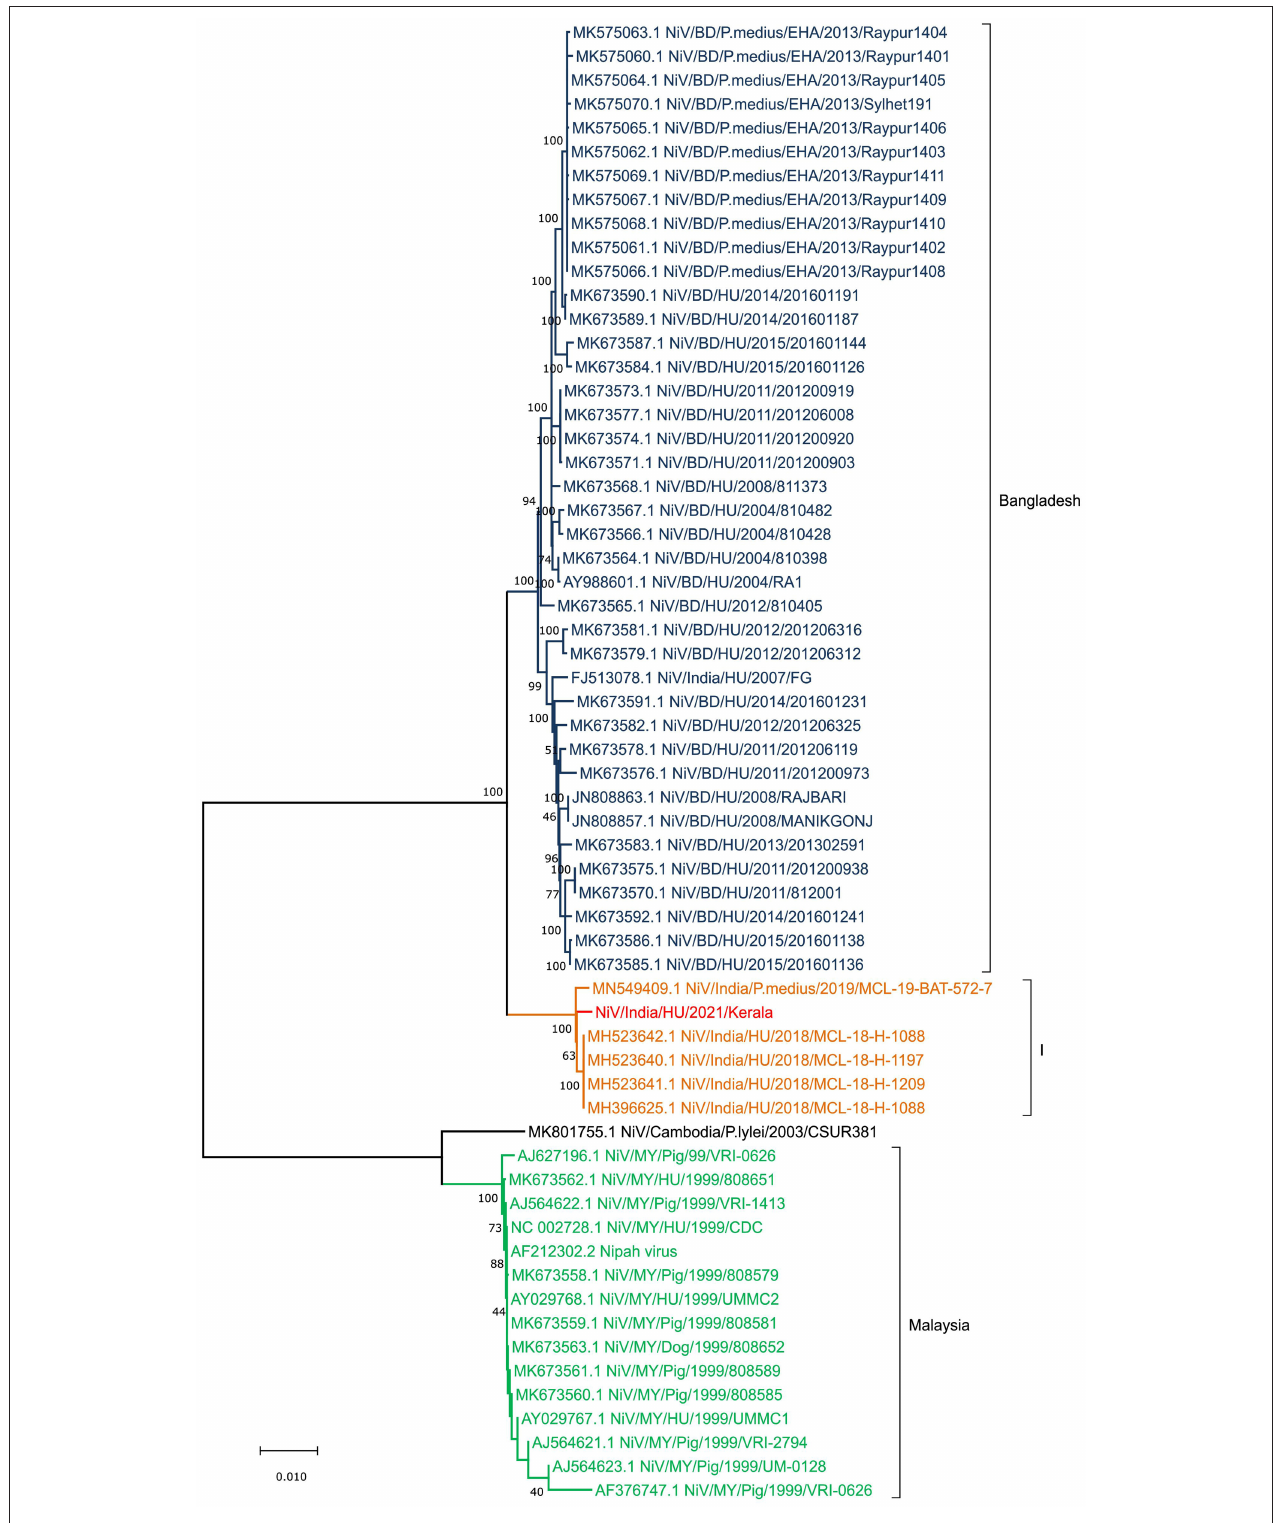
FIGURE 3 | Neighbor Joining tree of Nipah virus full genome obtained from the samples of the index case in Kerala outbreak 2021.